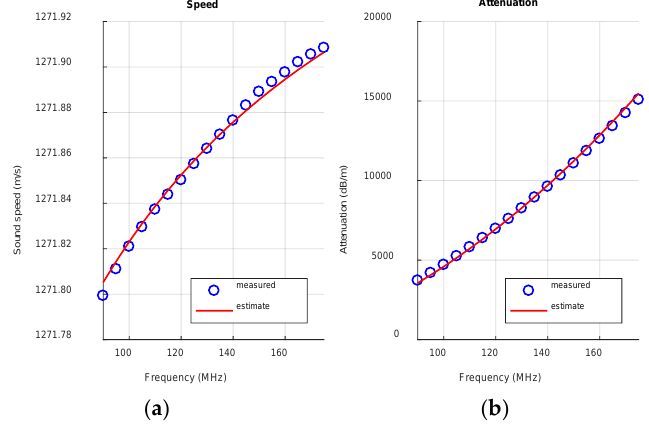
Figure 7. ( a ) Measured and estimated fit of the speed of sound and ( b ) attenuation, 30 min after the start of the Stöber reaction.